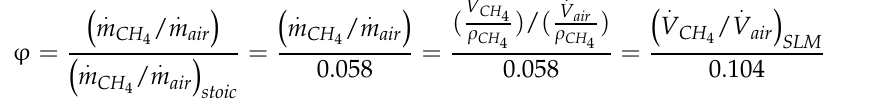
Figure 2. The working progress of pulsating air flow generator ( a ) in pulsating flow mode, and ( b ) in stable flow mode.